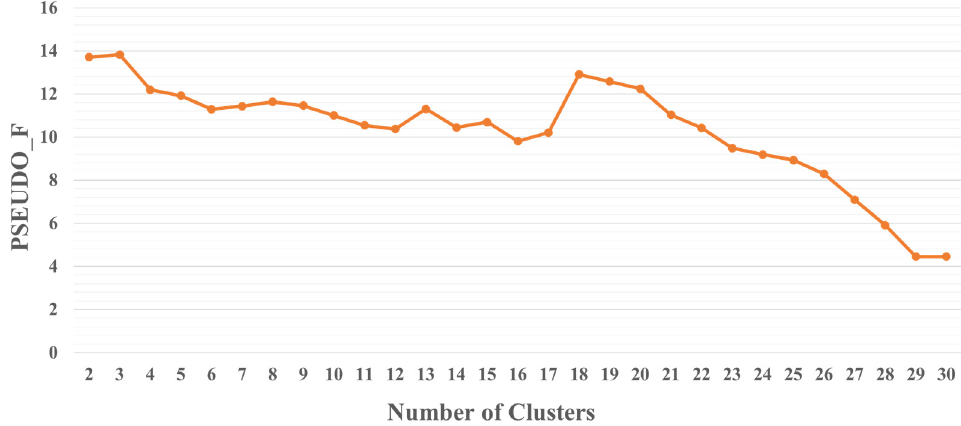
Figure 2. Pseudo-F index based region clustering basis.